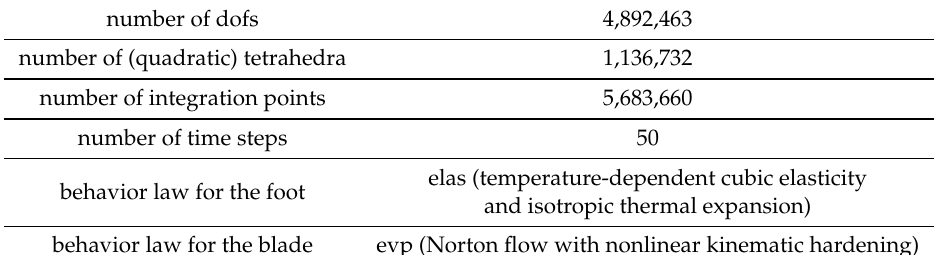
Table 5. Characteristics for the high-pressure turbine blade test case.